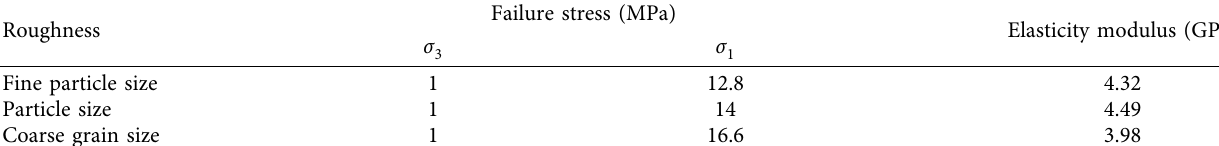
Table 2: Triaxial compression test results of fine sandstone specimens with different